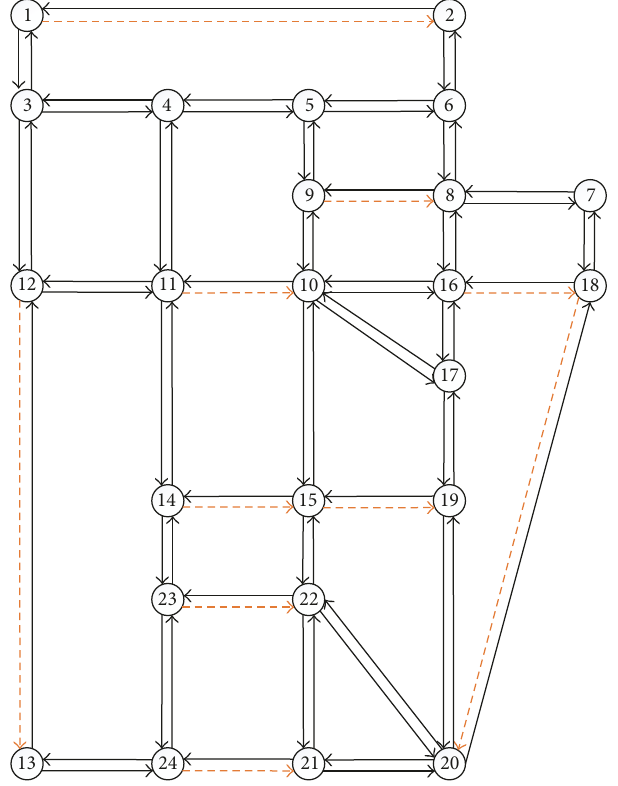
Figure 9: Network of Sioux